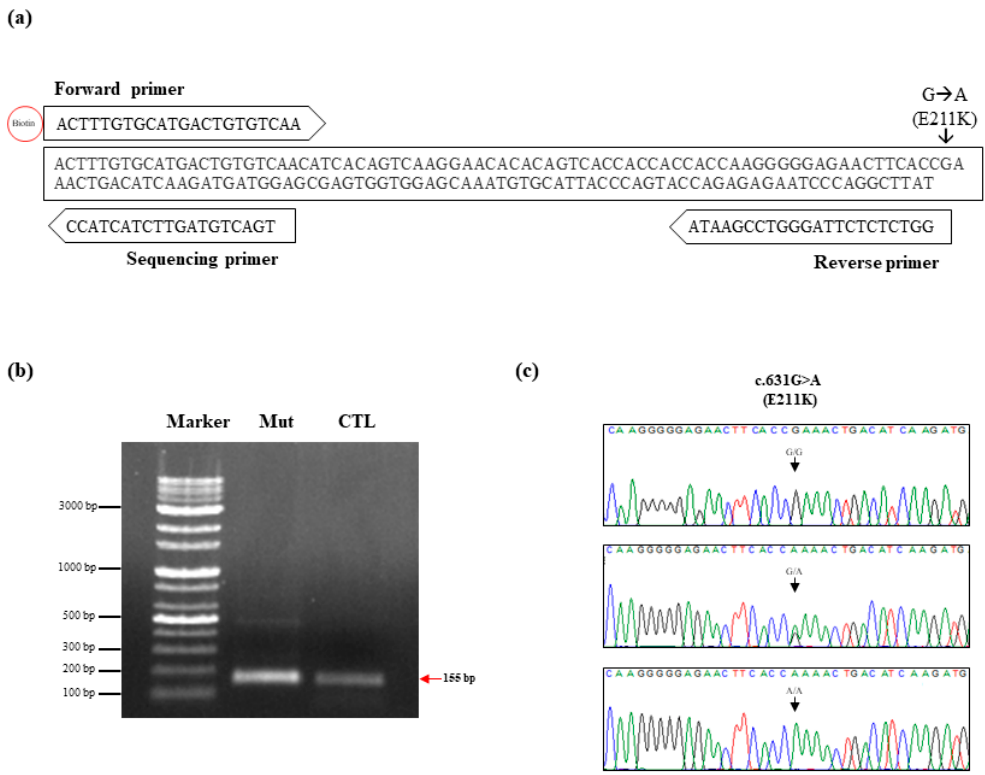
Table 2. Detailed information on the primer set used.